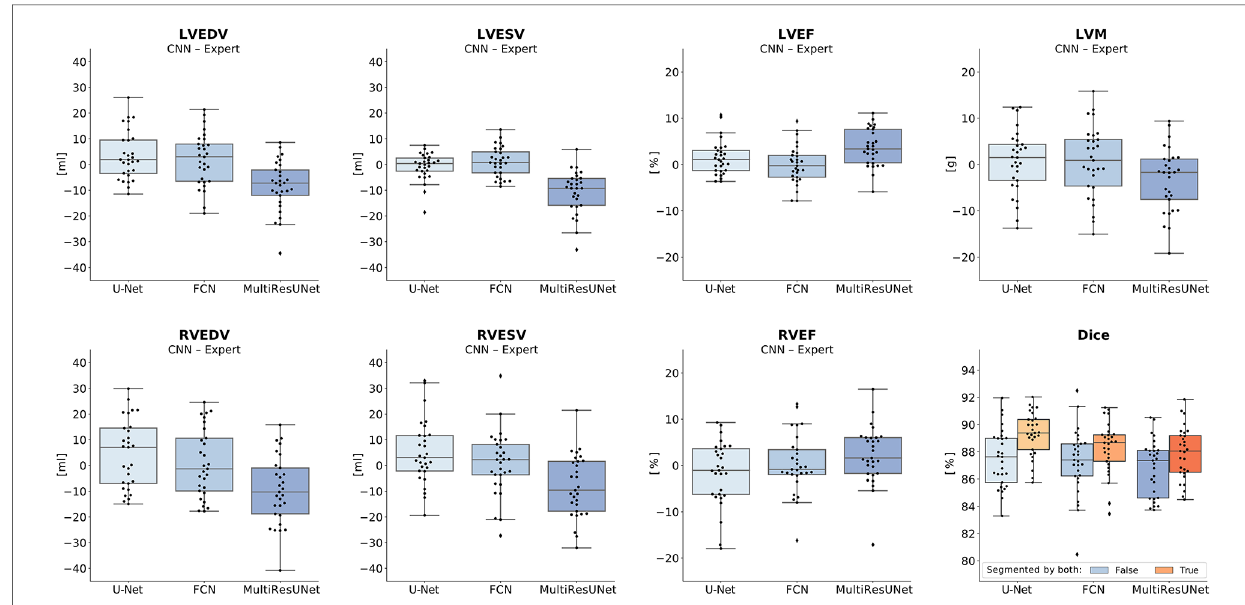
FIGURE 3 Candlelight plots of errors in clinical parameters and Dice values. Vertical boxplots show quantile one, median and quantile three of mean errors and Dice values for all test cases compared to the expert. The last graph displays two boxplots per network according to different de fi nitions of the Dice metric: one for all images, another limited to images segmented by both expert and CNN. Legend: CNN, convolutional neural network; LVEDV, left ventricular end-diastolic volume; LVESV, left ventricular end-systolic volume; RVEDV, right ventricular end-diastolic volume; RVESV, right ventricular end-systolic volume; LVEF, left ventricular ejection fraction; RVEF, right ventricular ejection fraction; LVM, left ventricular myocardial